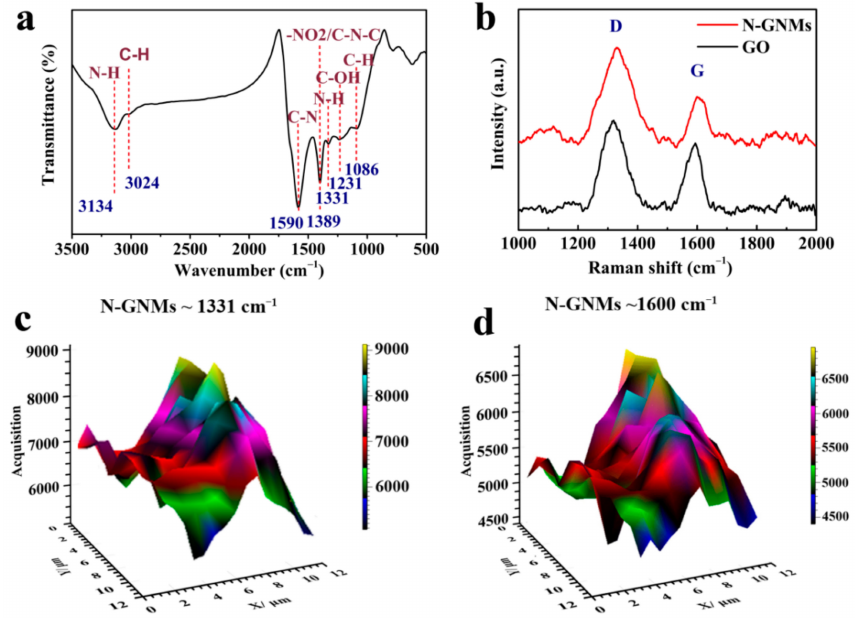
Figure 3. ( a ) Fourier transform infrared (FTIR) spectrum of the N-GNMs; ( b ) Raman spectra of the N-GNMs and GO; 3D spatial Raman mapping for N-GNMs ( c ) at ~1331 cm − 1 and ( d ) at ~1600 cm − 1 . The field of view was 12 µ m × 12 µ m with a pixel-to-pixel distance of 2 µ